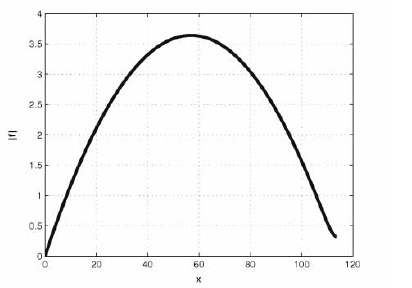
Figure 8. Stationary solution | f | (old), λ = 0, L = 113 . 7, N = 536, δ = 0, I = 0 . 002249.